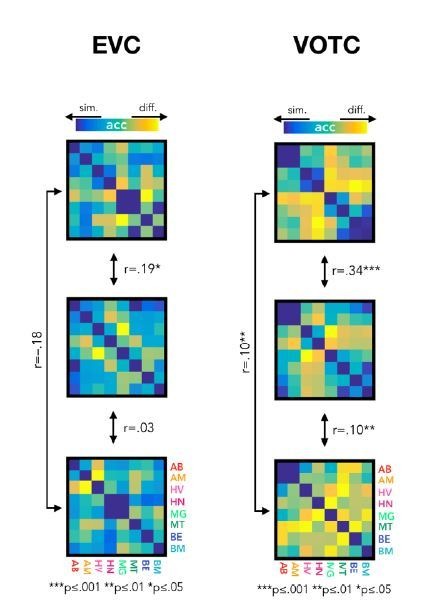
New version of the results from the correlation of brain DSMs in EVC (left) and in VOTC (right).Despite a reduction of size effect in the new results, there is not any major change in the statistical results.